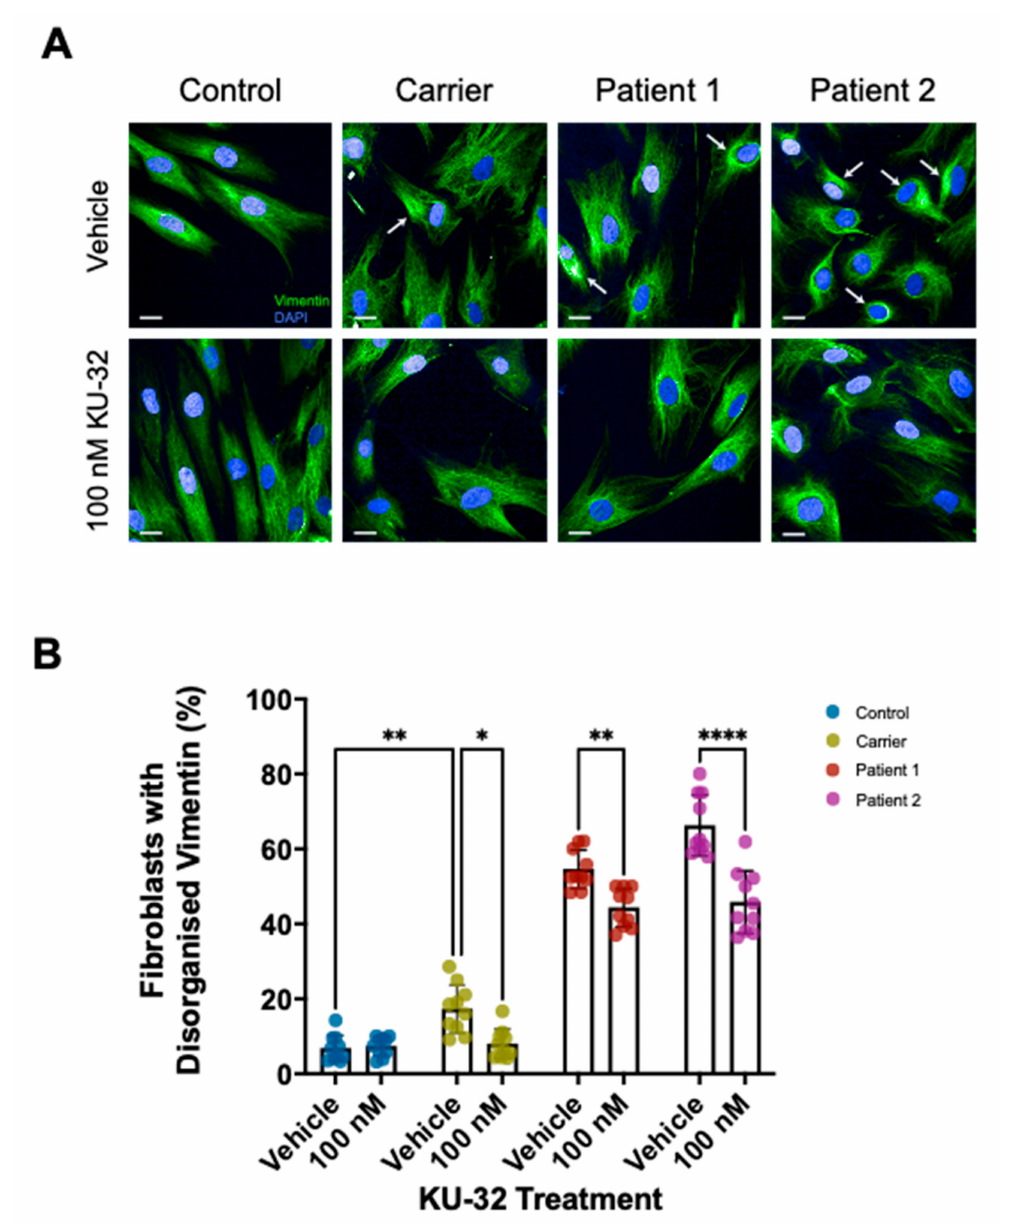
Figure 1. Reduction of vimentin bundling in dermal fibroblasts by KU-32 . Fibroblast lines were cultured for 24 h with either DMSO vehicle or 100 nM KU-32 prior to fixation and immunofluorescence. ( A ) Representative micrographs of Control, Carrier, Patient 1 and Patient 2 fibroblast lines with and without KU-32 treatment (Vimentin, green; DAPI, blue). Examples of cells with vimentin bundling are indicated with arrows. Scale bar = 20 µ m. ( B ) The percentage of cells with an abnormal vimentin network was then quantified for each cell line and treatment condition. Ten fields of view comprising >200 cells per cell line and treatment were analysed. Conditions were compared by two-way ANOVA with Tukey’s multiple-comparison post hoc analysis. KU-32 treatment significantly reduced vimentin bundling in the carrier and both patient lines but did not alter vimentin bundling in the control line. However, the vimentin bundling levels in the treated patient lines remained significantly higher than in control and carrier lines. * p ≤ 0.05; ** p ≤ 0.01; **** p ≤